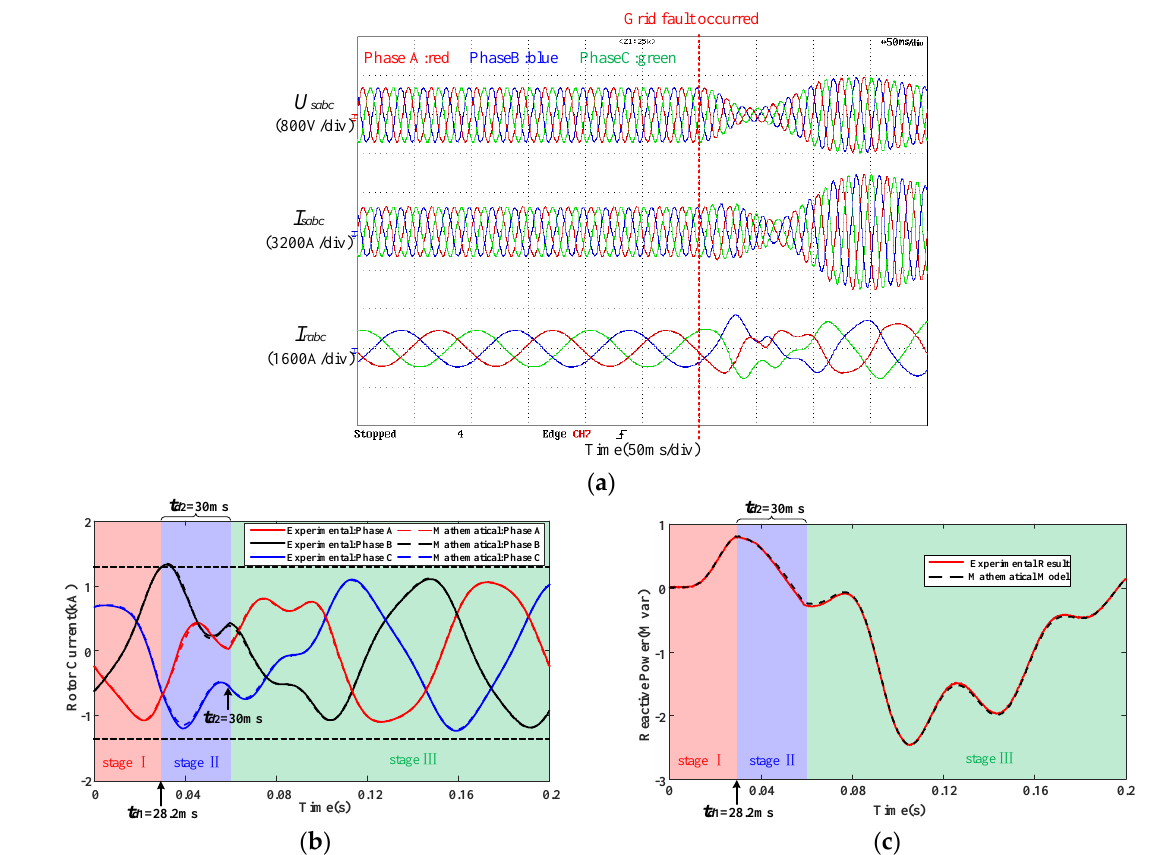
Figure 10. Grid voltage using the sending terminal grid under commutation failure. ( a ) Experimental results; ( b ) comparison of rotor current; ( c ) comparison of reactive power.